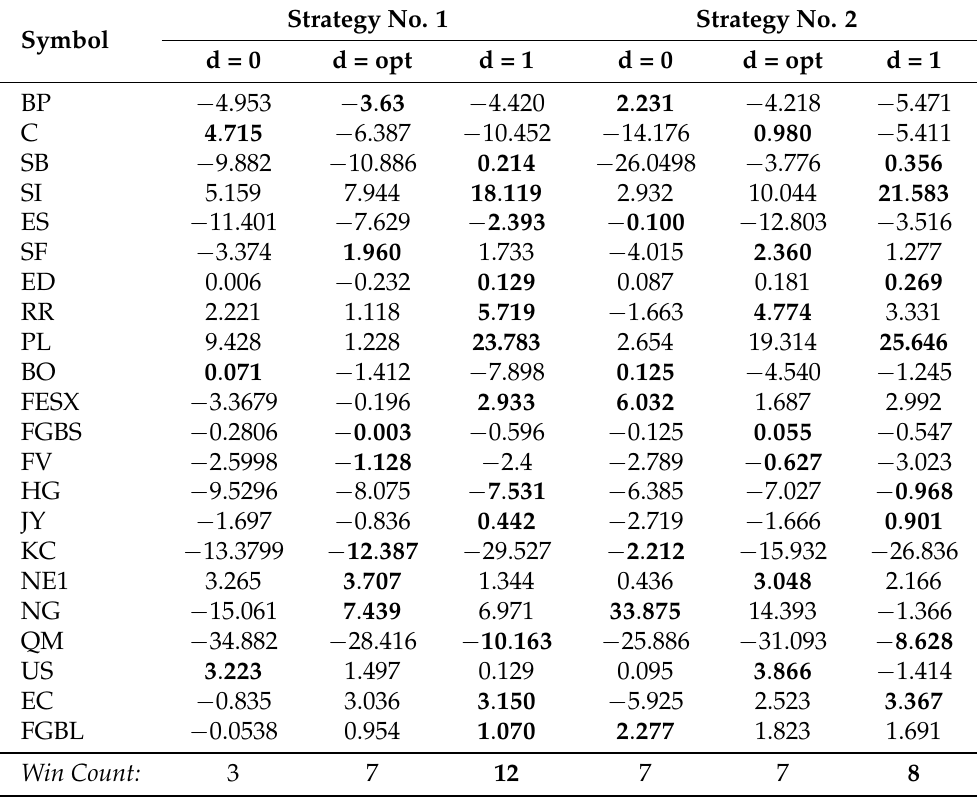
Table 4. Strategy returns using LSTM predicted prices.